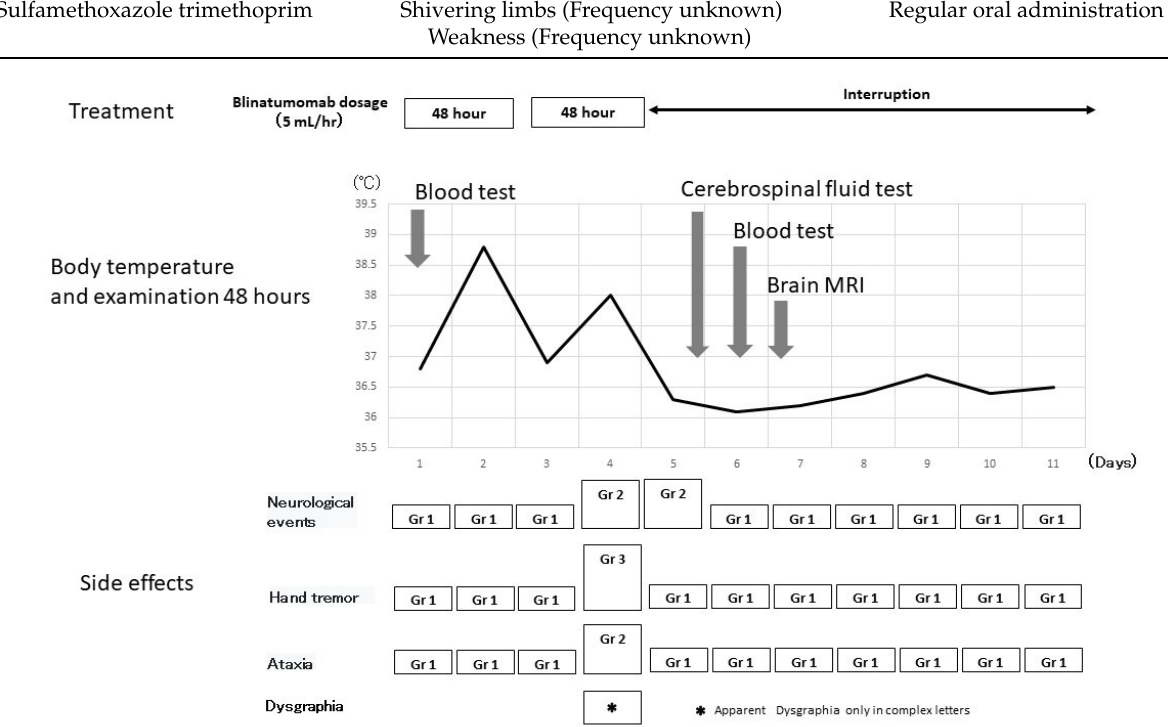
Figure 4. The clinical course of blinatumomab and side effects. Neuropathy appeared on Days 4–5. Brain magnetic resonance imaging and a cerebrospinal fluid examination did not reveal the cause of neuropathy. The patient’s symptoms improved rapidly after blinatumomab discontinuation. A writing disorder appeared on Day 4 of treatment. The severity of dysgraphia could not be graded because no grading system exists.